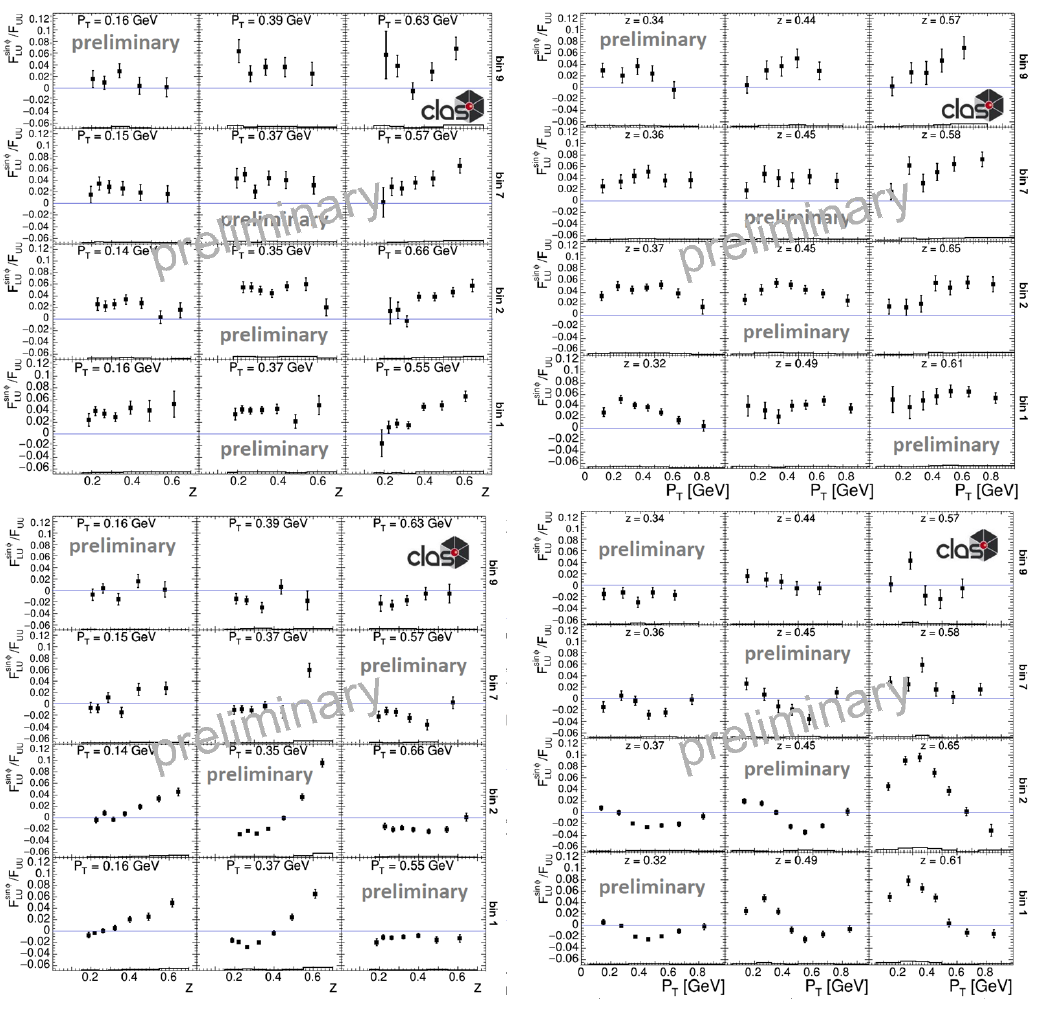
Figure 4: Upper panels: z dependence (left) and P φ / F F sin for π 0 in different P UU LU (left) and P dependence (right) of F sin T bins. A preliminary estimate of the systematic uncertainty is given by the histogram above the horizontal